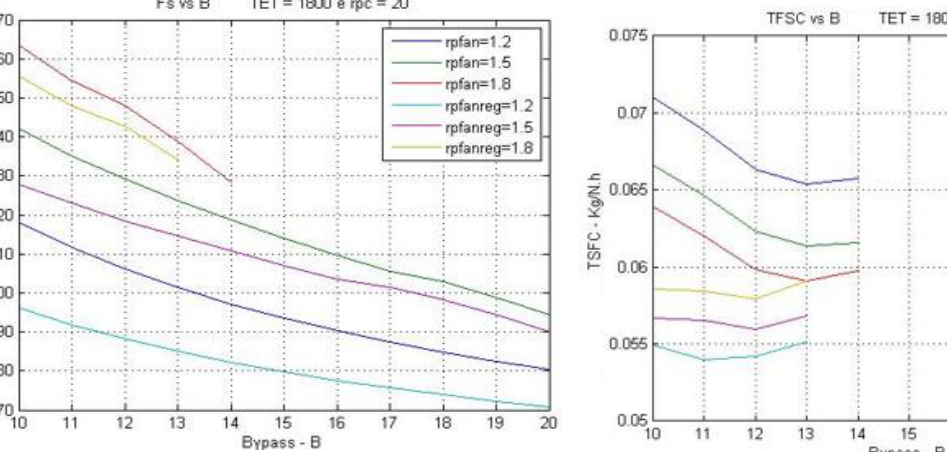
Figure 7: TSFC vs BPR with and without regeneration (TET 1800 K and rpfan 1.2).